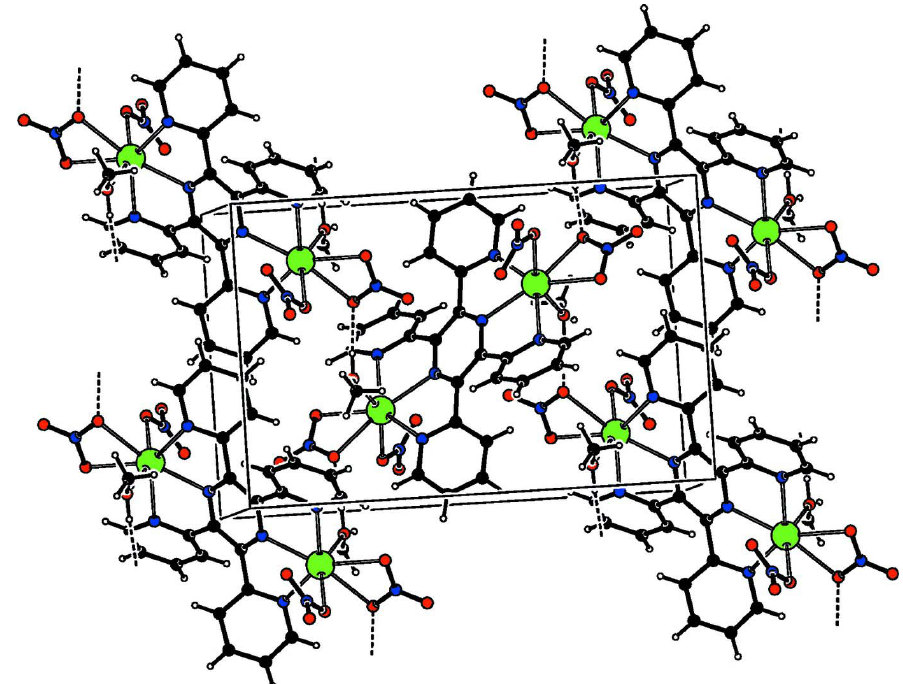
Figure 2 A packing diagram for the title molecule. Hydrogen bonds are shown as dashed